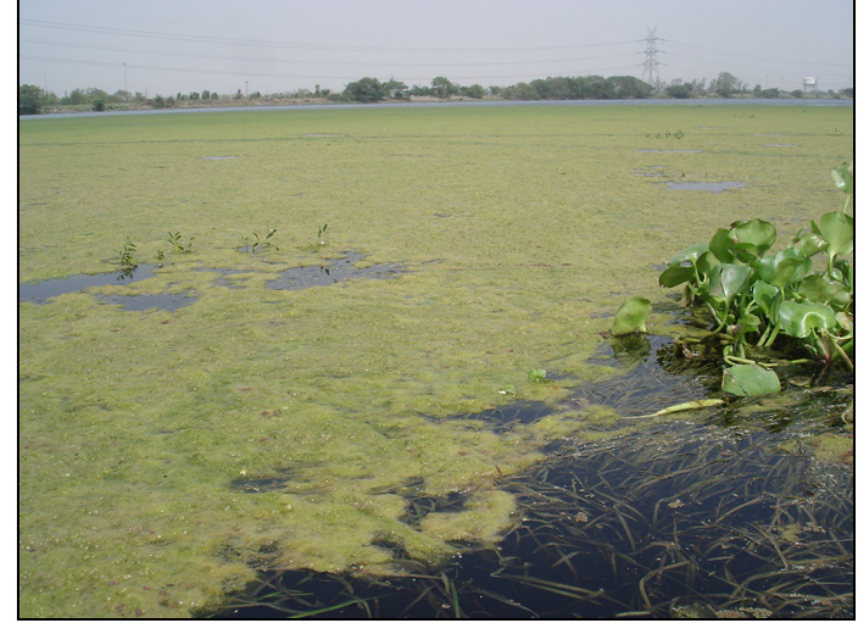
Fig. 3. Algal bloom and sub-merged vegetation community of the Sanctuary during present